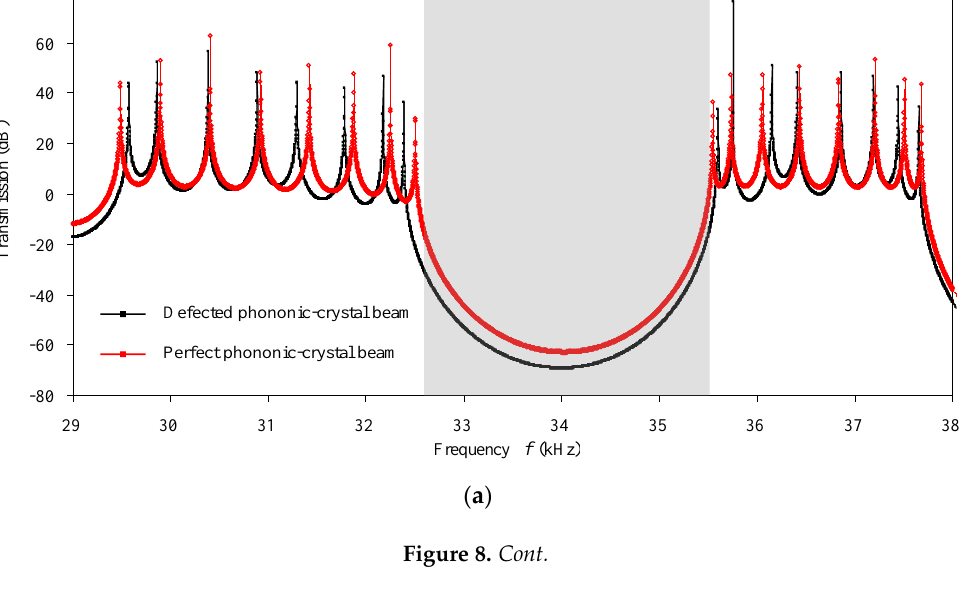
Figure 7. The transmissions and the band structures within low frequency range 2.5 kHz f ≤ : ( a ) Theoretical and experimental transmissions of the defected phononic crystal beam and the computed transmission of the counterpart perfect phononic crystal beam by the MRRM; ( b ) Band structures of the defected phononic crystal beam as a supercell by the TMM; ( c ) Band structures of the defected phononic crystal beam as a supercell by the MRRM; ( d ) Band structures of the perfect phononic crystal beam based on supercell of eight unit cells by the MRRM; ( e ) Band structures of the perfect phononic crystal beam based on one unit cell by the MRRM.